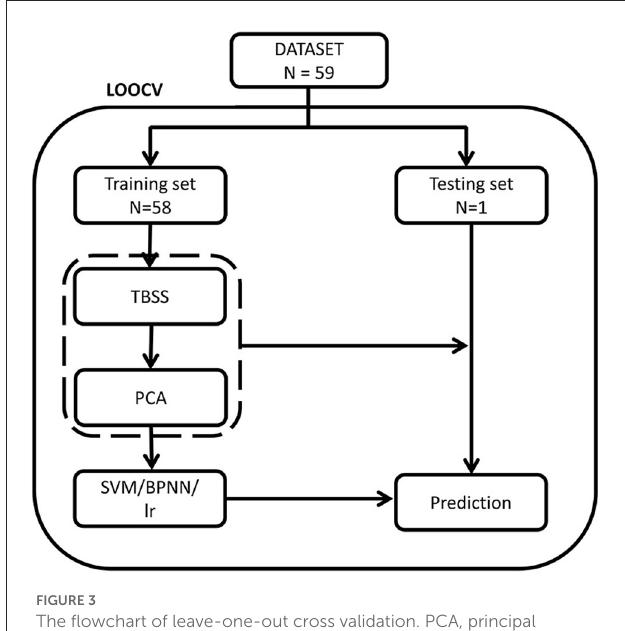
FIGURE3 The flowchart of leave-one-out cross validation. PCA, principal component analysis; SVM, support vector machine; LR, logistic regression; TBSS, tract-based spatial